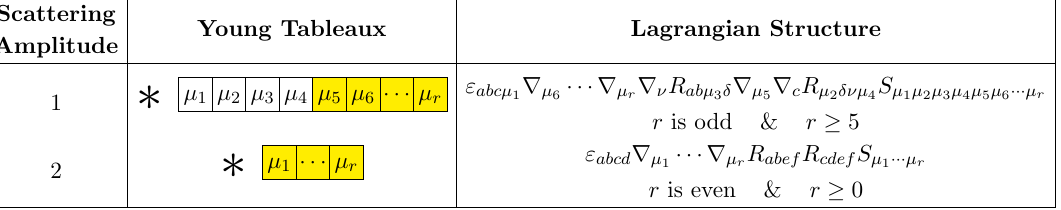
(cid:3) was explained in the caption to